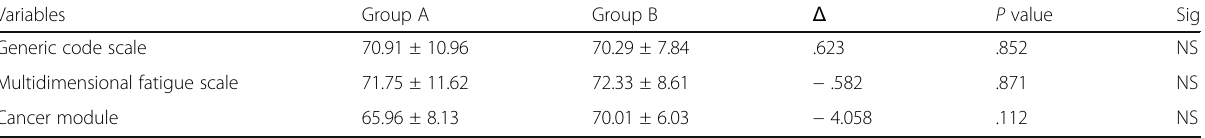
Table 7 Comparison of mean values of quality of life before treatment among groups A and B Variables